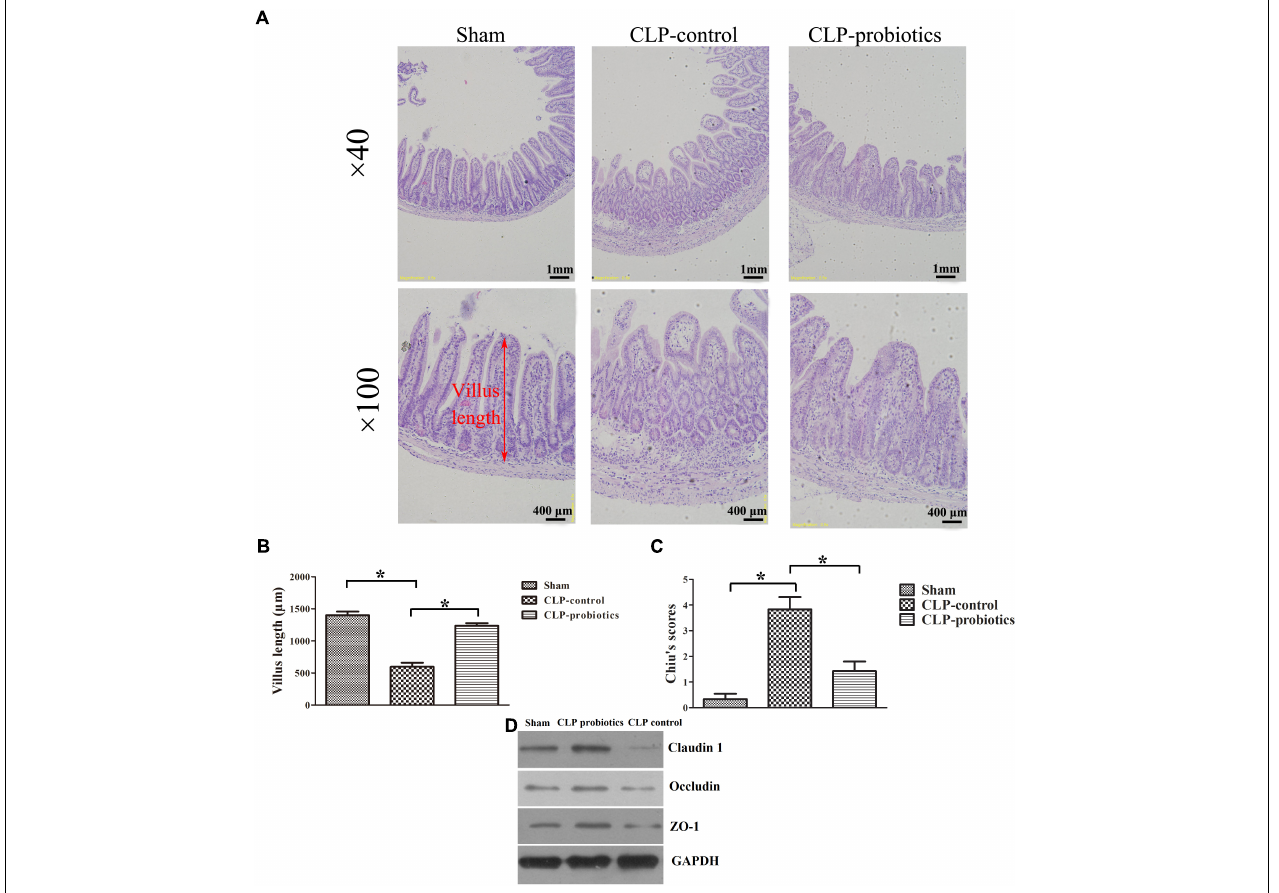
FIGURE 2 | Histological analysis of intestines and injury scores in septic mice with or without LCBE treatment. (A) Representative images of HE staining sections of ileal in sham, CLP-control and CLP-probiotic groups under 40 × and 100 × magnification. (B) Villus length was determined to evaluate the impairments of ileal quantified in 12 oriented crypt-villus units. LCBE enteric-coated capsule pretreatment reduced the villus length. (C) Intestinal injury scores were evaluated using the Chiu’s grading system. (D) The expression of TJ proteins (ZO-1, claudin-1 or occludin) in ileal tissues were analyzed by Western blotting. All data were expressed as means ± SEM. N = 6 mice/group; ∗ P <